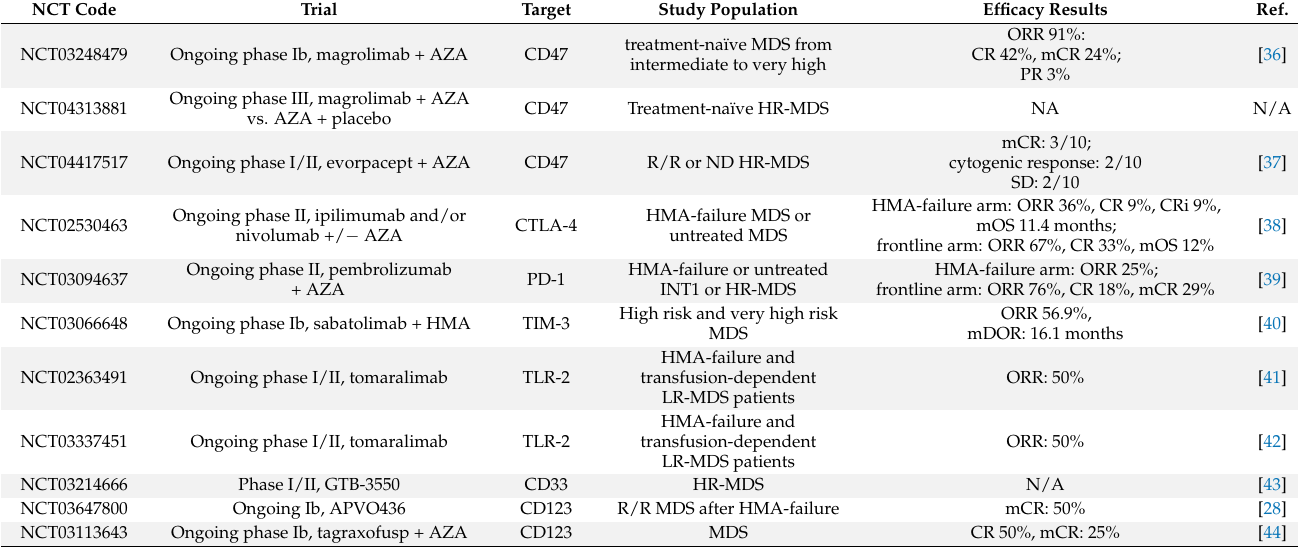
Table 2. Clinical trials with innovative mAb in